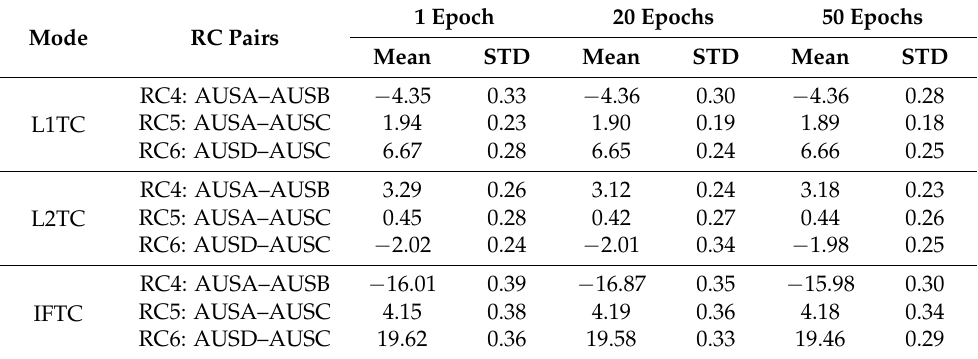
Figure 3. Mean and standard deviation of ISB estimations. The columns from left to right correspond to the L1TC, L2TC, and the IFTC method, respectively. In the L1TC part, the columns from left to right are the ISB estimations of receiver pairs RC1, RC2, RC3, RC4, RC5, and RC6, respectively. The L2TC part and the IFTC part are also the same as the L1TC part. The mean of ISB estimations in the real test is represented by the red bar, denoted as E-MEAN. The mean of the theoretical ISB estimations is also represented by the red bar, denoted as T-MEAN. The STD of the ISB estimations in real test are represented by the blue stem. Table 5. Statistics of ISB estimations with different initial epochs (m). Mode